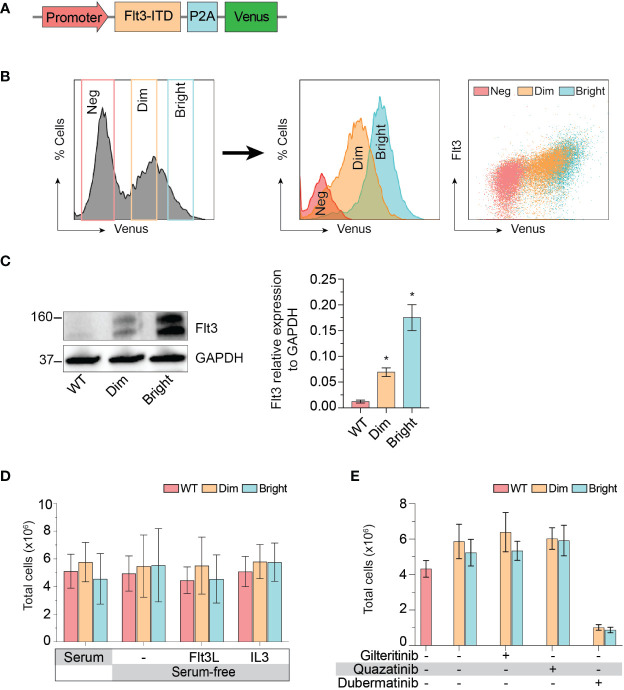
Effect of Flt3-ITD on K562 response to inhibitors. (A) Schematic diagram of Flt3-ITD overexpressing cassettes. (B) Flow cytometric histogram showing gating strategy used for fluorescent-activated cell sorting. Sorted cells were analyzed several weeks after expansion and showed stably expressed Flt3. Neg, negative. (C) Western blot showing total Flt 3 protein expression from wild type, dim, and bright K562. Representative pictures from three independent experiment are shown. Bar graph showing mean±SD of Flt3 protein expression relative to GAPDH. * indicates significance compared with wild type. (D) Cell proliferation profile of wild type, dim, and bright K562 cultured under indicating conditions for 72 h. Bar graph showing mean±SD from three independent experiments performing in parallel. Flt3L, Flt3 ligand; IL3, interleukin 3. (E) Cell proliferation profile of wild type, dim, and bright K562 treated with indicating 4 nM gilteritinib, 8 nM quizartinib, and 100 nM dubermatinib for 72 h. Bar graph showing mean ± SD from three independent experiments performing in parallel.